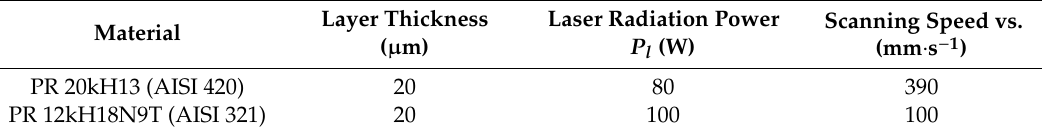
Table 2. Laser powder bed fusion factors for growing solids. 10 ± 0.1.